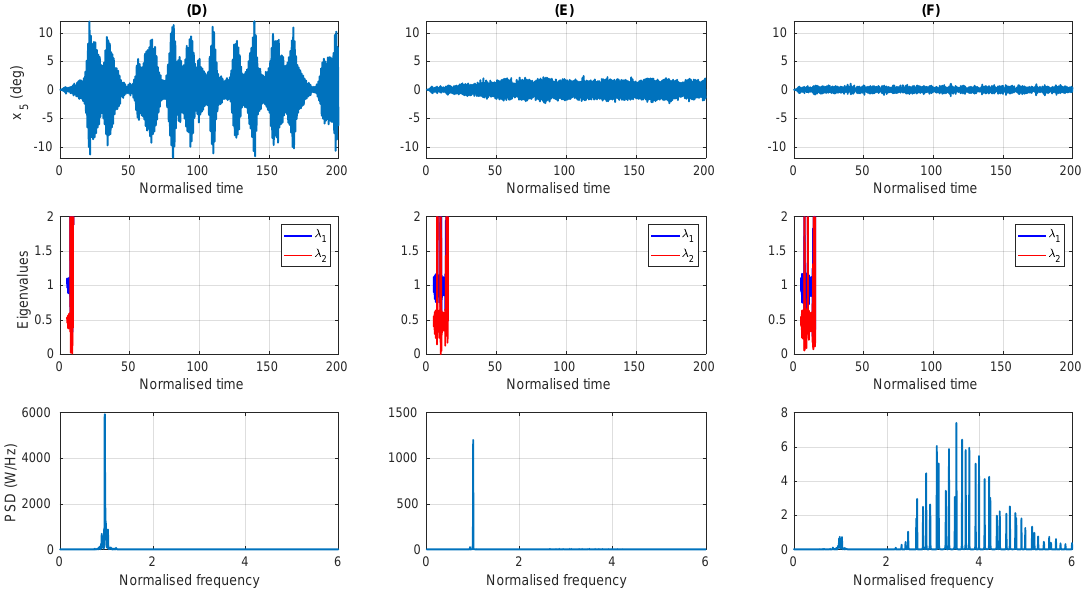
Figure 16. The time series for the pitch displacement ( top ), the magnitudes of the eigenvalues of the matrix A ( middle ) and the PSD of the pitch displacement ( bottom ), for the points (D) D, (E) E and (F) F in Figure